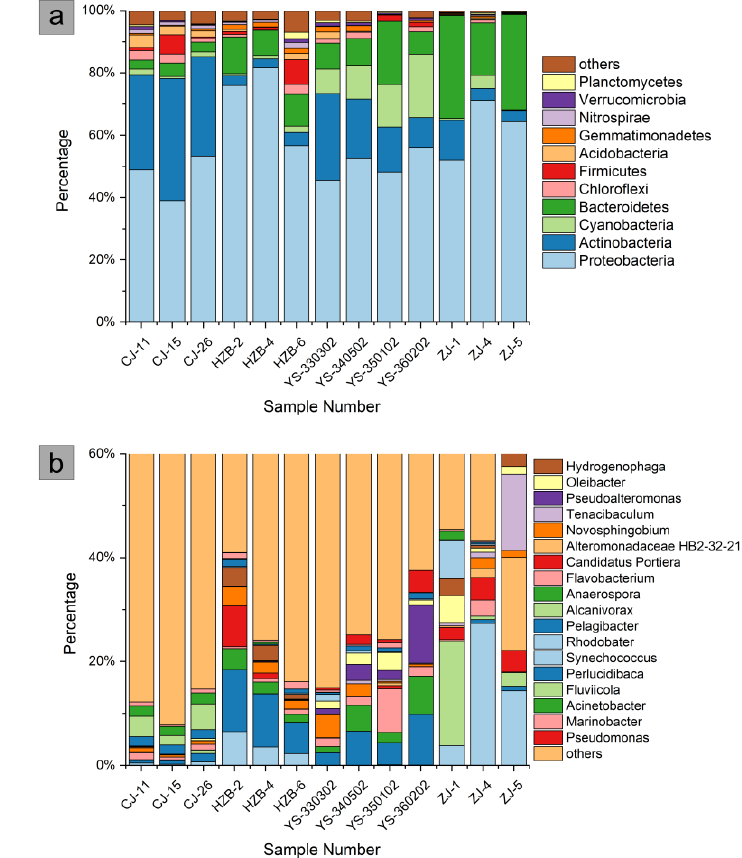
of − 0.876, 0.804, and 0.580, respectively, which demonstrates their greater impact on the microbial community (Figure 10). Figure 8. Taxonomic barplot of bacteria at the phylum level ( a ) and genus level ( b ) in the Yangtze Estuary (CJ), Hangzhou Bay (HZB), Yellow Sea (YS), and Pearl River Estuary (ZJ).